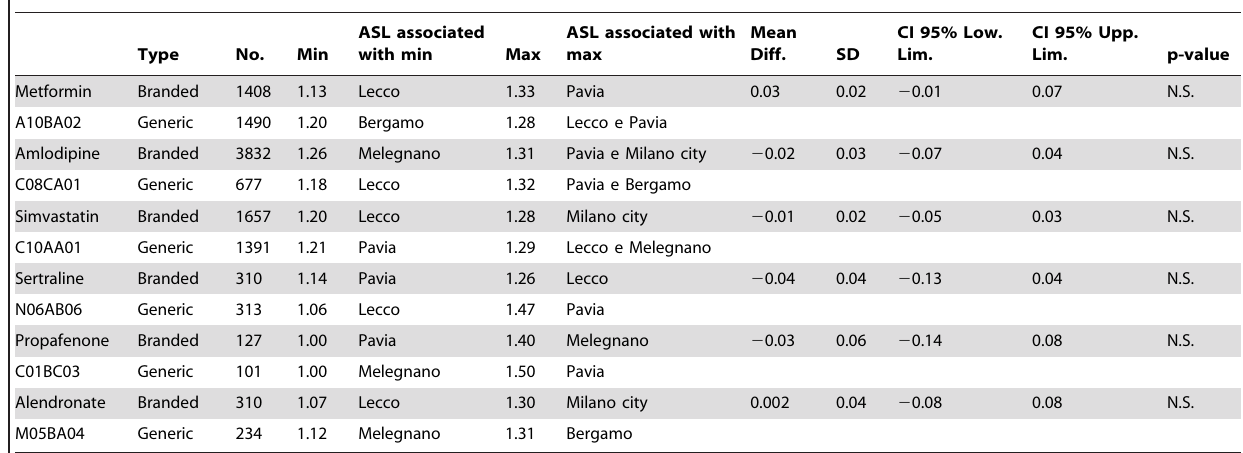
Table 4. Hospitalizations in persistent patients (mean number of hospitalizations).